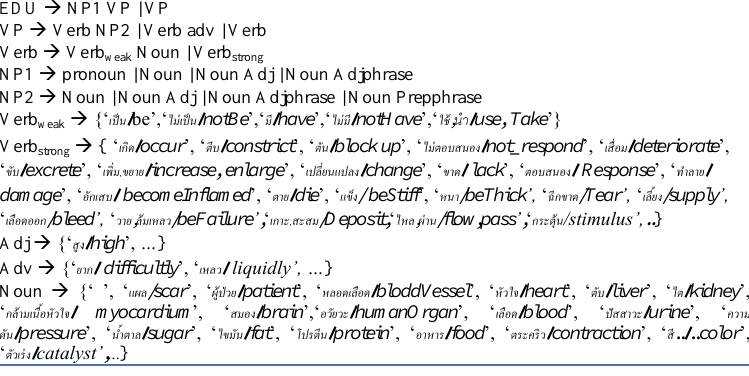
Figure 1. The general Thai linguistic expression of EDU after stemming words and eliminating stop words.